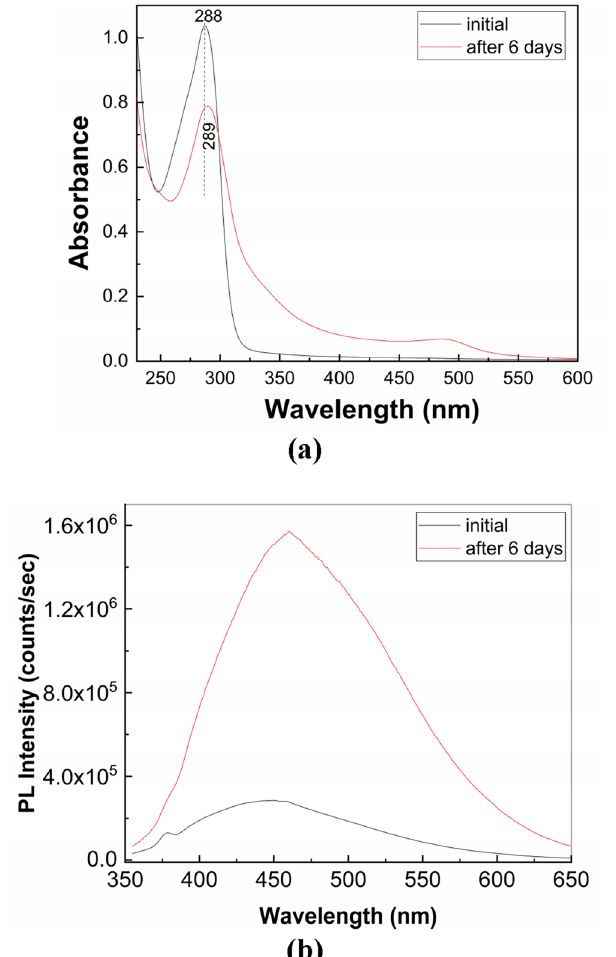
Figure 8. The UV–VIS ( a ) and PL ( b ) spectra of the solution of PS (1; 2 mg/ml) in BP with the pH = 8 and their evolution after the storage time of 6 days. Black and red solid lines correspond to the UV–VIS and PL spectra of the PS (1) solutions prior and after the storage time of 6